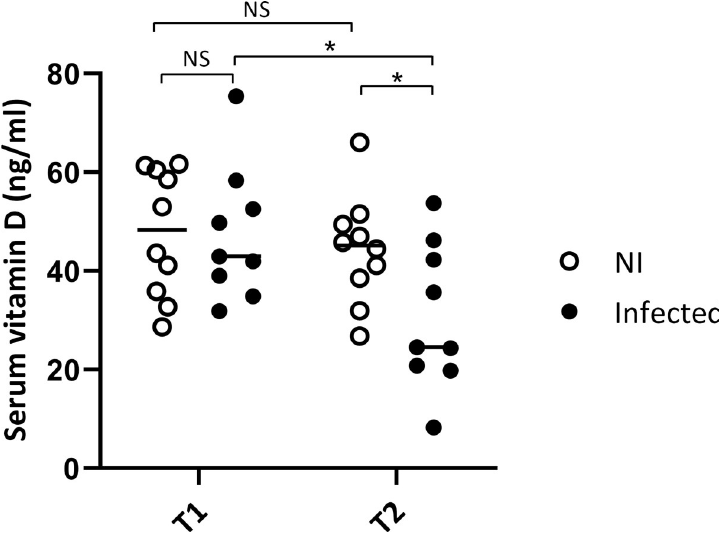
Fig 2. Serum vitamin D concentration in a dog population living in Spain. Vitamin D status in dogs was assessed according to the serum levels of 25-hydroxyvitamin D estimated with an ELISA test. Comparison between Non- Infected dogs (NI) and Infected dogs during the longitudinal study (Infected) at the inclusion point (T1) and at the end of the study (T2) ( � P < 0.05).